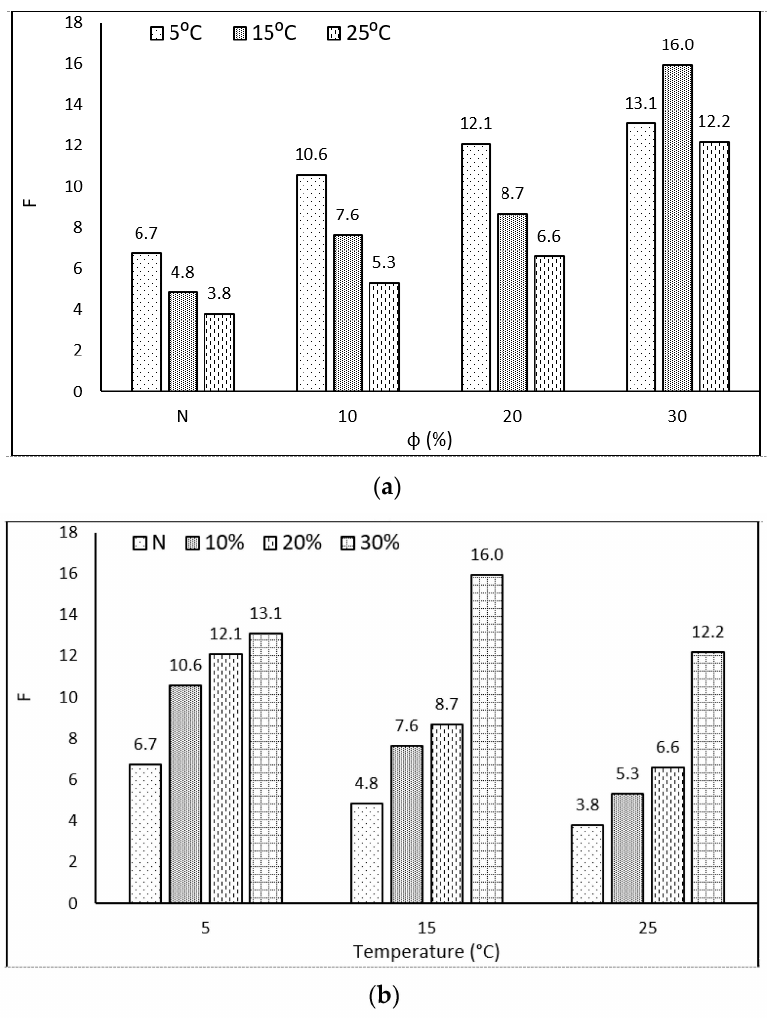
Figure 5. Variation in F parameter with the change in ( a ) testing temperature and ( b ) filler